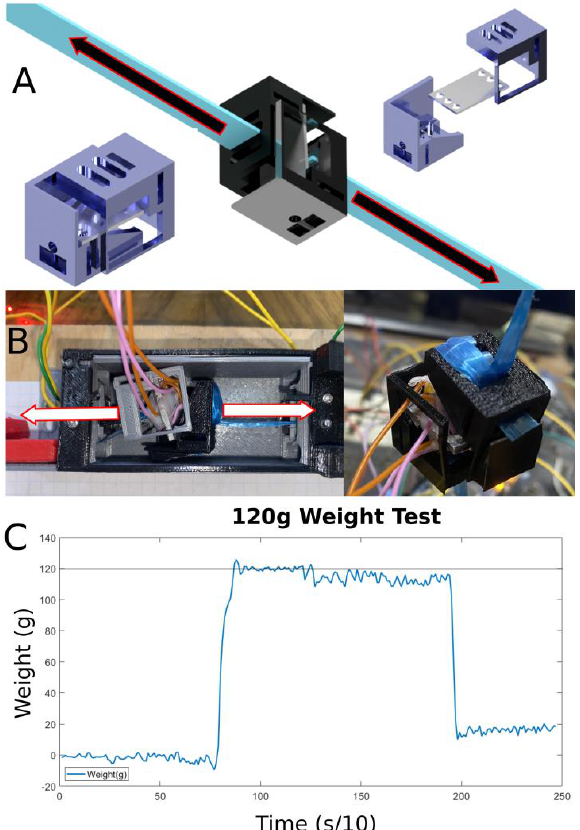
Figure 6. Details for the tendon tension sensing approach. ( A ) Different views of the CAD model illustrating the details of the design. ( B ) Images of the loadcell after fabrication and assembly. ( C ) Graph showing the loadcell’s reading when placing a 120 g weight on it.